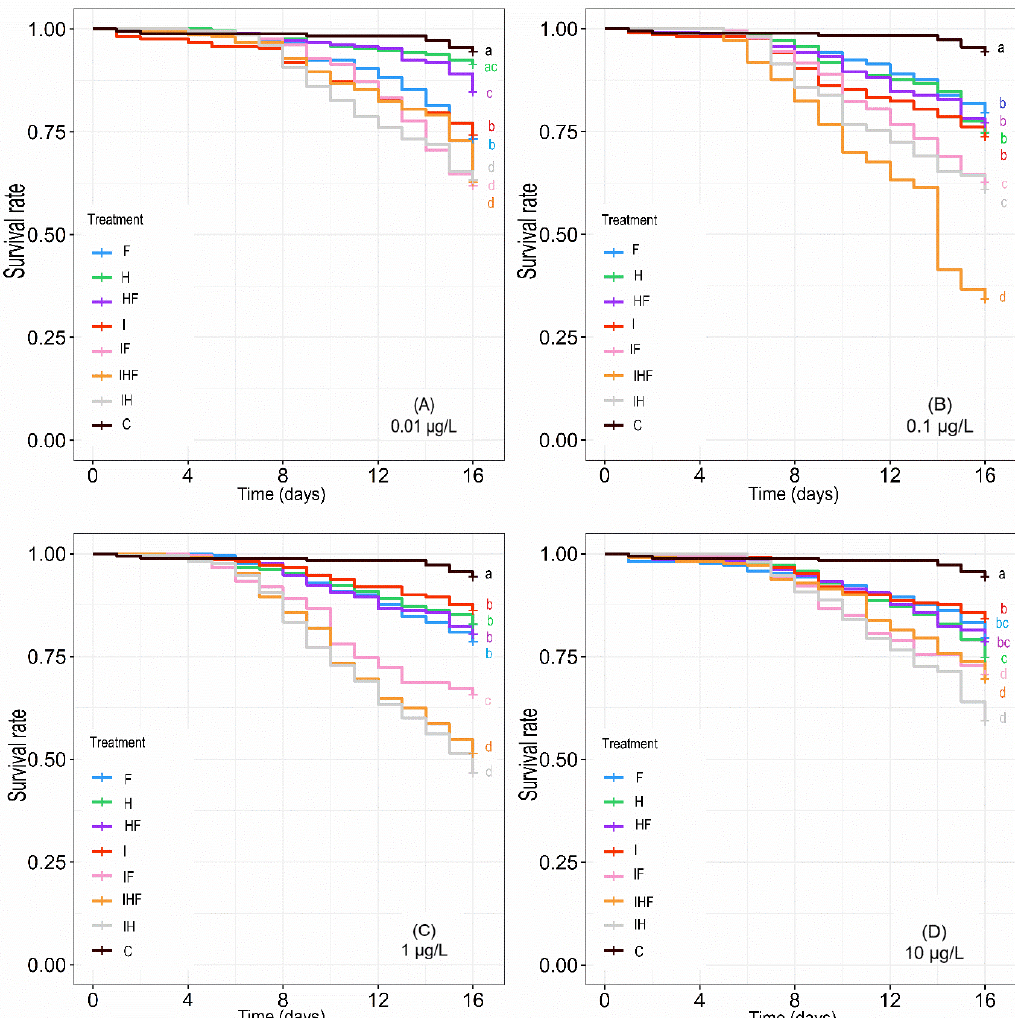
Figure 1. Effects of pesticides alone or in mixtures on honey bee survival. Winter honey bees were orally exposed to food containing no pesticides (C), imidacloprid (I), difenoconazole (F), glyphosate (H), imidacloprid + difenoconazole (IF), imidacloprid + glyphosate (IH), glyphosate + difenocona- zole (HF), or imidacloprid + glyphosate + difenoconazole (IHF) at concentrations of 0.01 µg/L ( A ), 0.1 µg/L ( B ), 1 µg/L ( C ) and 10 µg/L ( D ). The survival rate was followed until day 16 of exposure, at which bees were sampled for physiological analyses. The data represent the mean proportion of surviving honey bees. The mortalities from 14 replicates of 30 bees per treatment were analyzed using the Kaplan–Meier method followed by a post hoc test for comparison of survival between treatments. Data with different letters are significantly different ( p < 0.05). 3.2. Effects of Pesticides on Feeding Behavior The influence of pesticide treatments on the feeding behavior of honey bees was fol- lowed by measuring the daily food consumption (Figure 2). The individual cumulative food consumption was used to detect possible differences between treatments. As a gen- eral feature, honey bees exposed to pesticides consumed an equal amount of food com- pared to that consumed by unexposed bees, except for the bees of H0.01 that consumed relatively less food than controls (753.7 mg/bee and 852.3 mg/bee, respectively (Table S3)). When comparing the cumulative individual food consumption between different doses